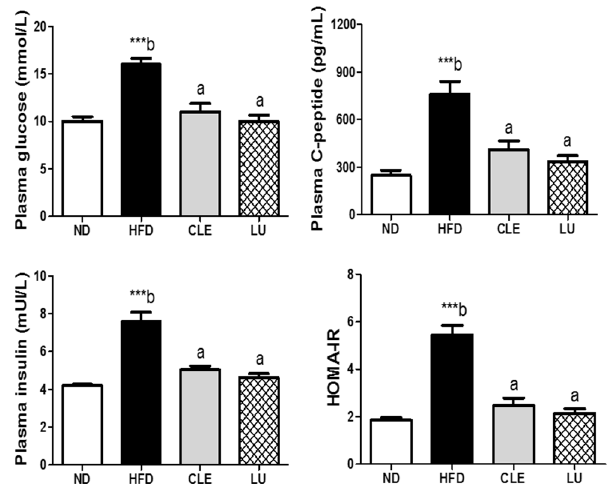
Figure 3. E ff ect of chrysanthemum leaf ethanol extract and luteolin supplements for 16 weeks on the hepatic steatosis-related markers in C57BL / 6J mice fed a high-fat diet. ( A ) morphology and masson’s trichrome stain in liver (magnification × 200); ( B ) hepatic lipid levels ( C ) expression of hepatic lipid-regulating genes ( D ) hepatotoxicity index. Data are mean ± SE. Significant di ff erences between HFD compared to ND are indicated * p < 0.05, ** p < 0.01, and *** p < 0.001 (Student’s t -test). ab Means not sharing a common letter are significantly di ff erent among the HFD-fed groups at p < 0.05. ND, normal diet (AIN-76); HFD, high-fat diet (45% kcal from fat); CLE, HFD + chrysanthemum leaf ethanol extract (1.5%, w / w ); LU, HFD + luteolin (0.003% w / w ); H&E, hematoxylin and eosin; MT, masson’s trichrome; GOT, glutamic oxalacetic transaminase; GPT, glutamic pyruvic transaminase.